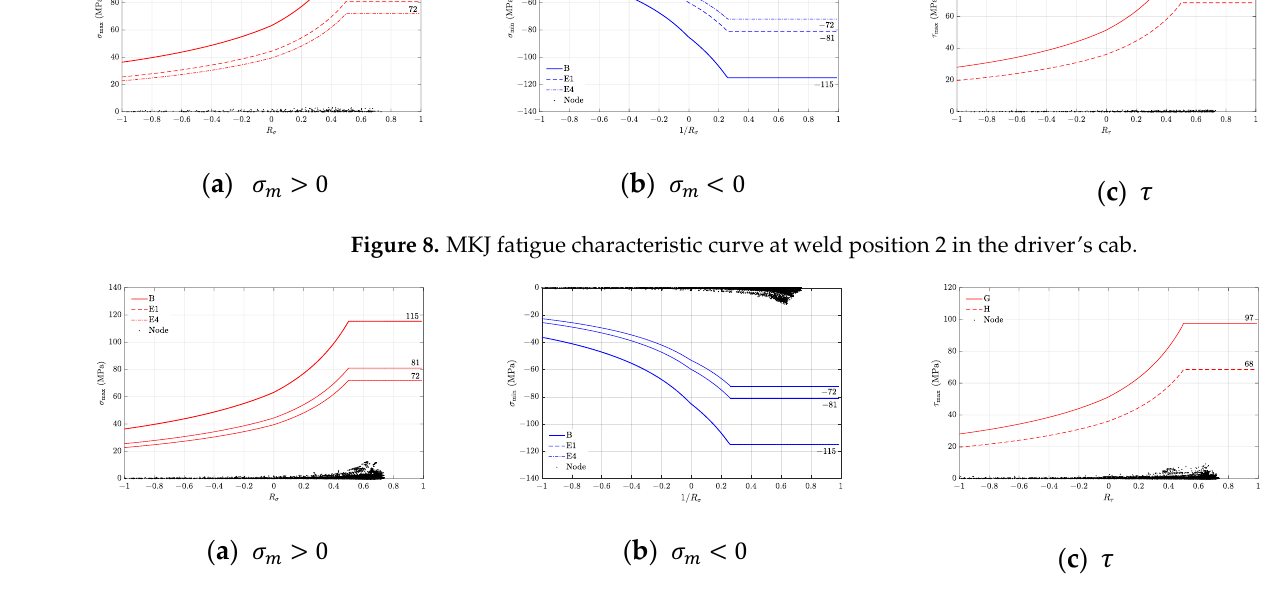
Figure 9. MKJ fatigue characteristic curve at weld position 3 in the underframe area.